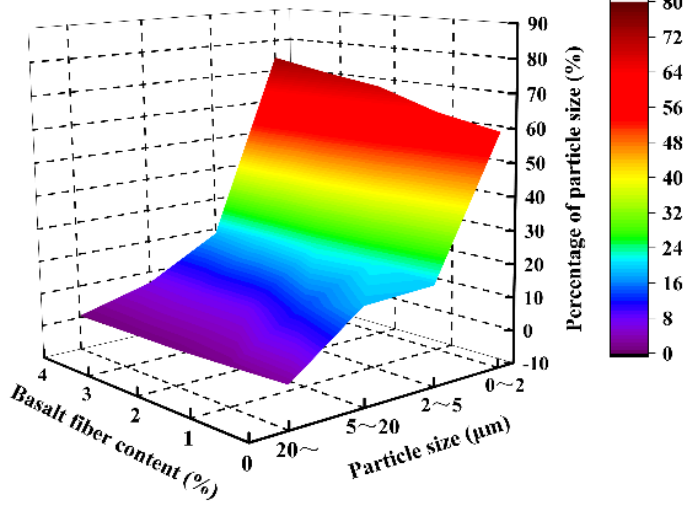
Figure 11. Particle size distribution.